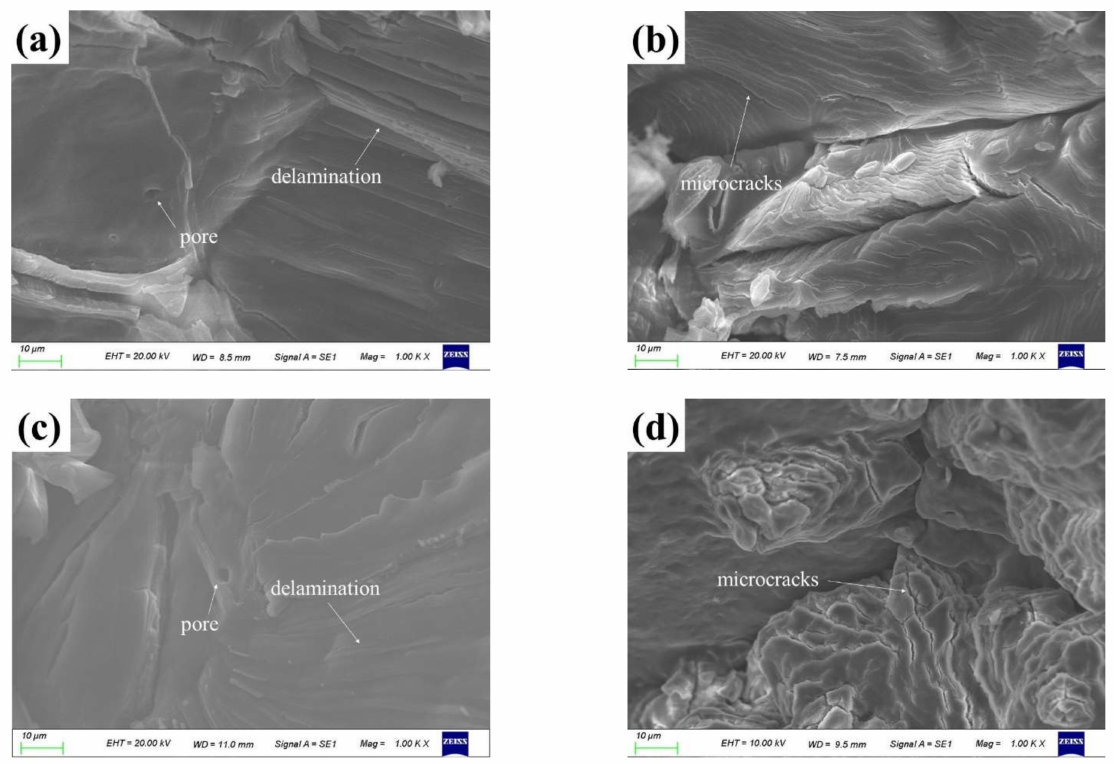
Figure 7. High magnification SEM micrographs of fracture surfaces for tensile specimens at: ( a ) RT; ( b ) 500 ◦ C and that for 3PB specimens at ( c ) RT; ( d ) 500 ◦